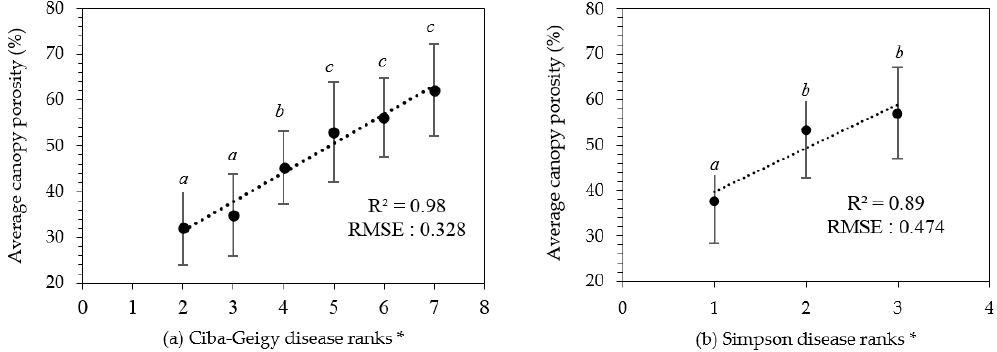
Figure 5. Results of derived canopy porosity values against disease ranks ( a ) Ciba-Geigy ( b ) Simpson. * Error bars indicate the standard deviation for each category. Averaged with similar letters are not significantly different from each other at p < 0.05.